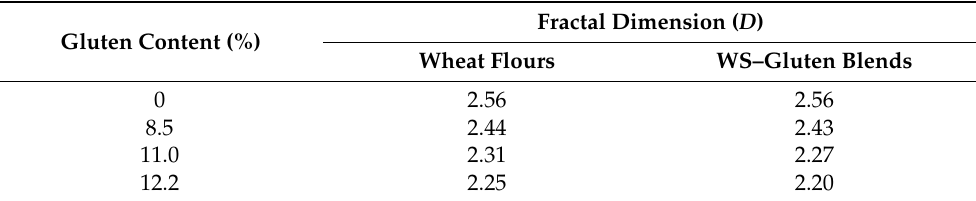
Figure 6. SAXS patterns and their fitted curves for the films: ( A ) pure WS, wheat flours with different protein contents (8.5%, 11.0%, and 12.2%), and ( B ) WS–gluten blends with different protein contents (8.5%, 11.0%, and 12.2%). Table 3. Fractal structure parameters for the films of pure WS, wheat flours, and WS–gluten blends with different protein contents (8.5%, 11.0%, and 12.2%).